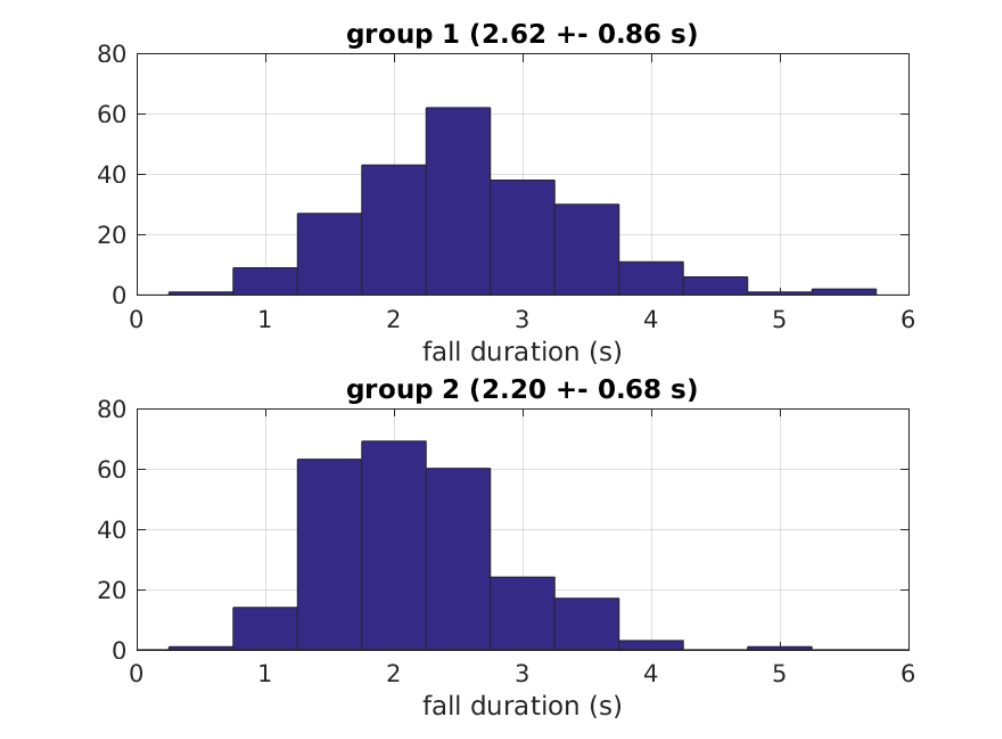
Figure 7. Seconds per fall for each